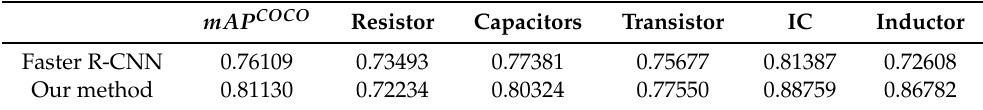
Table 4. mAP coco on testing dataset and per category of bounding box mAP coco